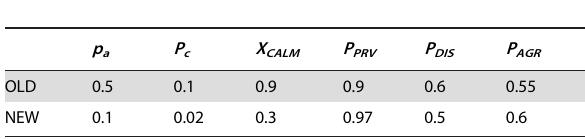
Table 3. Best fit parameters used in reproducing the political affiliation, emotional content of messages and the type of messages.